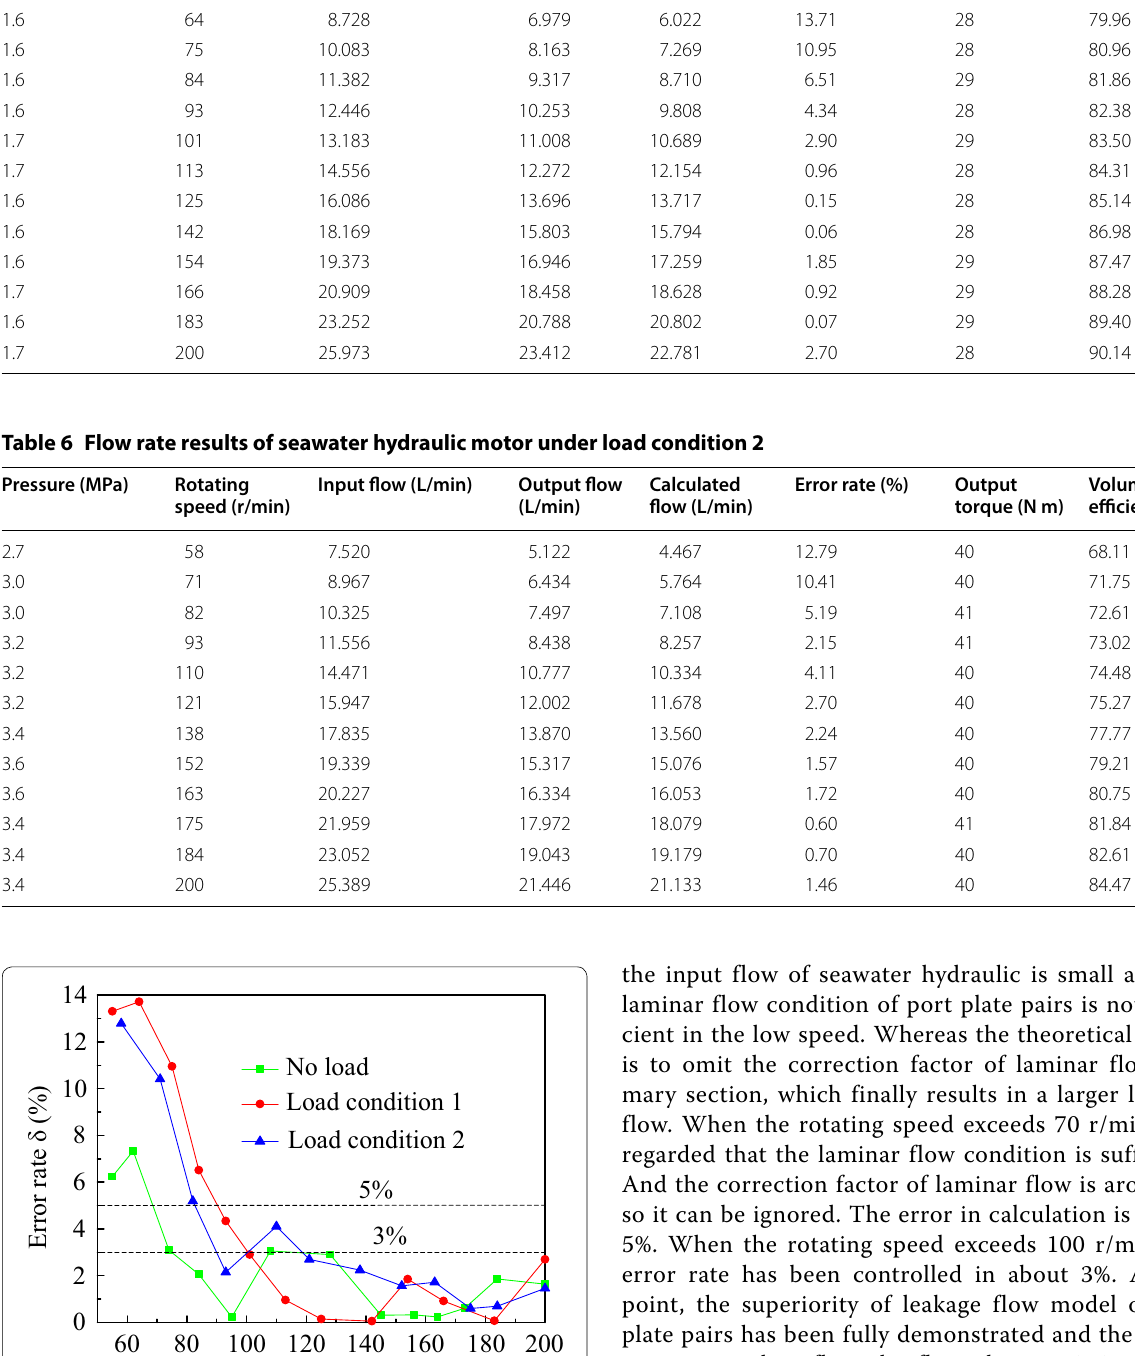
Table 5 Flow rate results of seawater hydraulic motor under load condition 1 Pressure (MPa) Rotating speed (r/min)